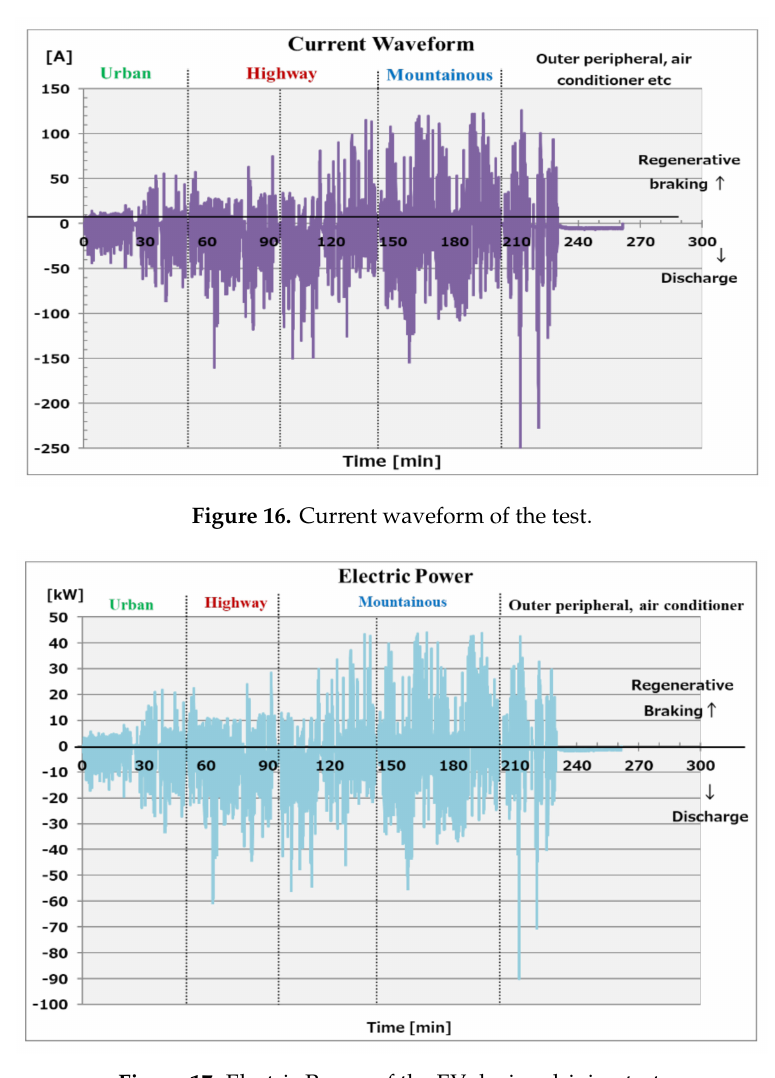
Figure 17. Electric Power of the EV during driving